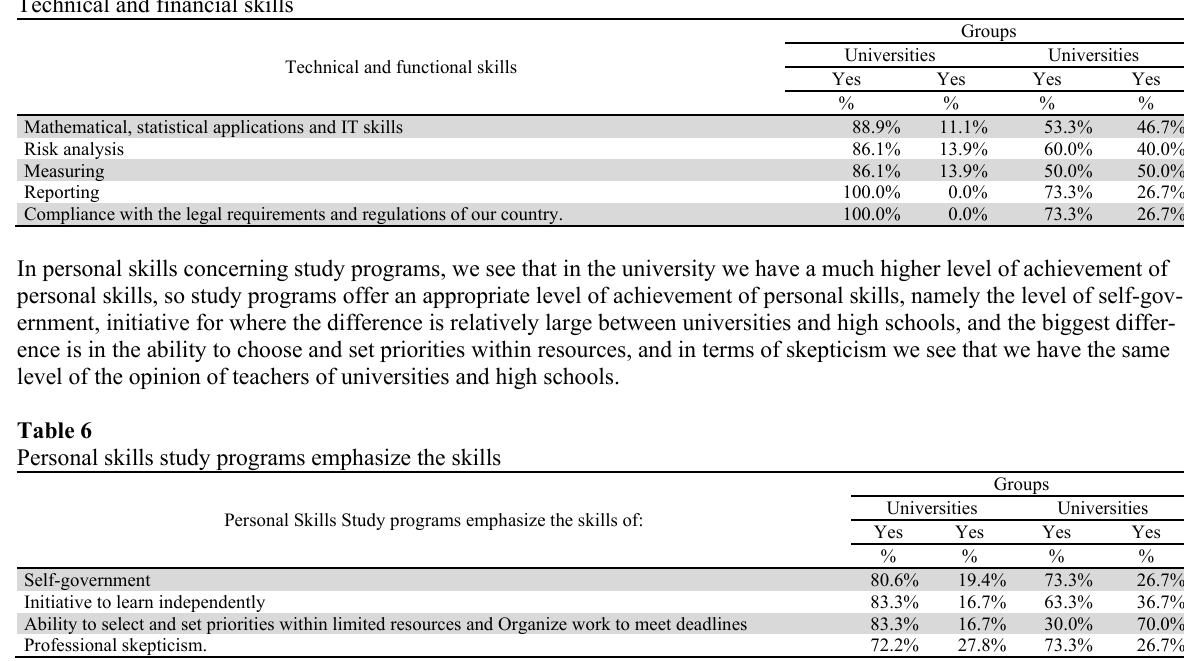
Communication skills